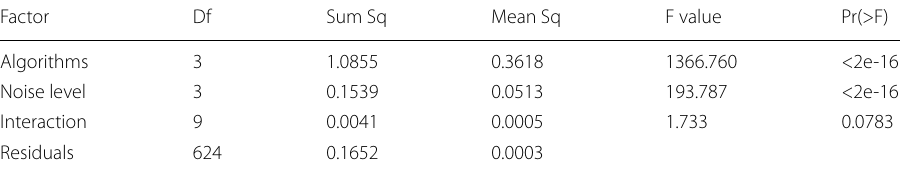
Table 5 Two-factor ANOVA for AUC